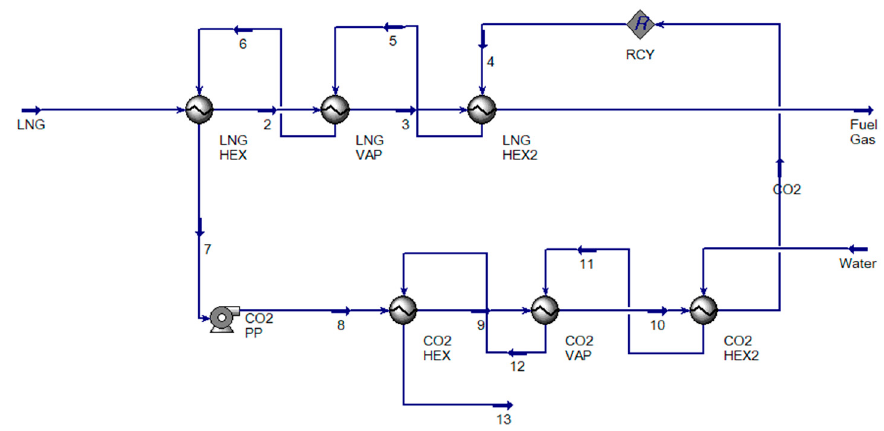
Figure 2. Schematic diagram of the CO 2 system.